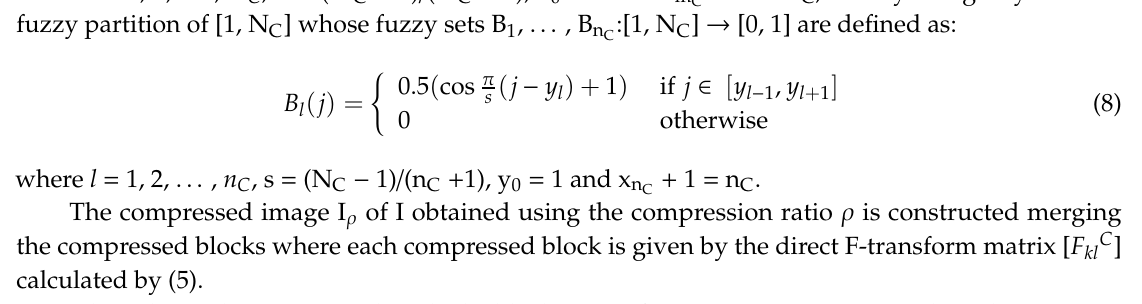
Algorithm 1 shows in pseudocode the block F-transform image compression algorithm. Algorithm 1. Block F-Transform Image